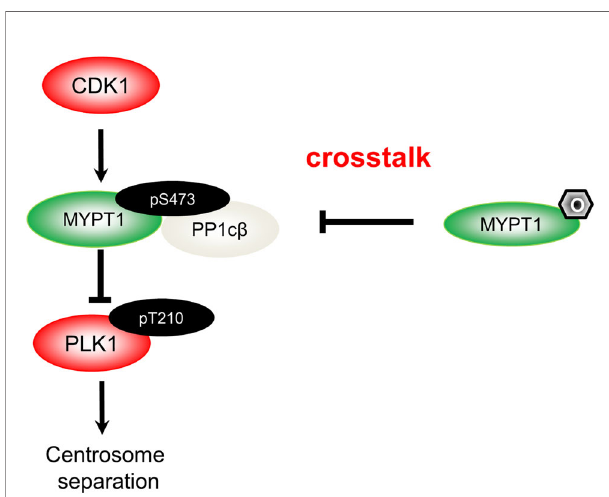
FIGURE 1 | A diagram spotlights the role of O-GlcNAcylation in centrosome separation based on our work (15). During mitosis, CDK1 phosphorylates MYPT1 at pS473 to be docked onto PLK1. Hence, MYPT1 recruits PP1c b to dephosphorylate and inactivate PLK1 (17). MYPT1 has been shown to be O-GlcNAcylated (18). In our recent work (15), we demonstrated that MYPT1 O-GlcNAcylation at four major sites antagonizes pS473, dissociates MYPT1 from PLK1. Thus by elevating PLK1 pT210, O-GlcNAcylation induces untimely separation of centrosomes.